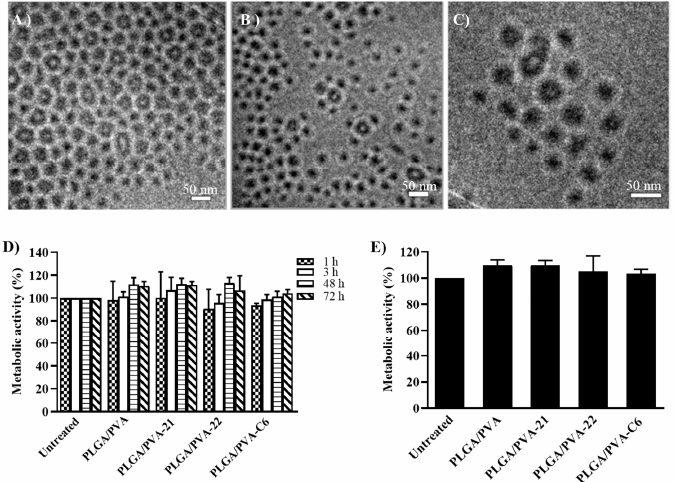
Figure 2. Characterization of PLGA/PVA SQ NPs by cryoTEM is shown for PLGA/PVA ( A ), PLGA/PVA-21 ( B ), and PLGA/PVA-22 ( C ). Scale bars are 50 nm. Cell viability measured by percentage of metabolic activity of LAD2 cells exposed to SQ NPs PLGA/PVA-21 and PLGA/PVA-22, in comparison to untreated controls, were determined 1, 3, 48, and 72 h after treatment, and analyzed by the XTT assay (( D ), n = 3, ±SEM). LAD2 cells treated with PLGA/PVA NPs after 24 h treatment ( E ). 3.3. Effect of NPs on the Viability of LAD2 Cells Although PLGA/PVA NPs did not trigger significant cytotoxicity, the PLGA/PVA- SQ combination could be cytotoxic to the human mast cells over longer periods of expo- sure. Consequently, the effect of PLGA/PVA-SQ NPs on the LAD2 viability was measured over a 72-h period (Figure 2d). No significant metabolic changes were observed on LAD2